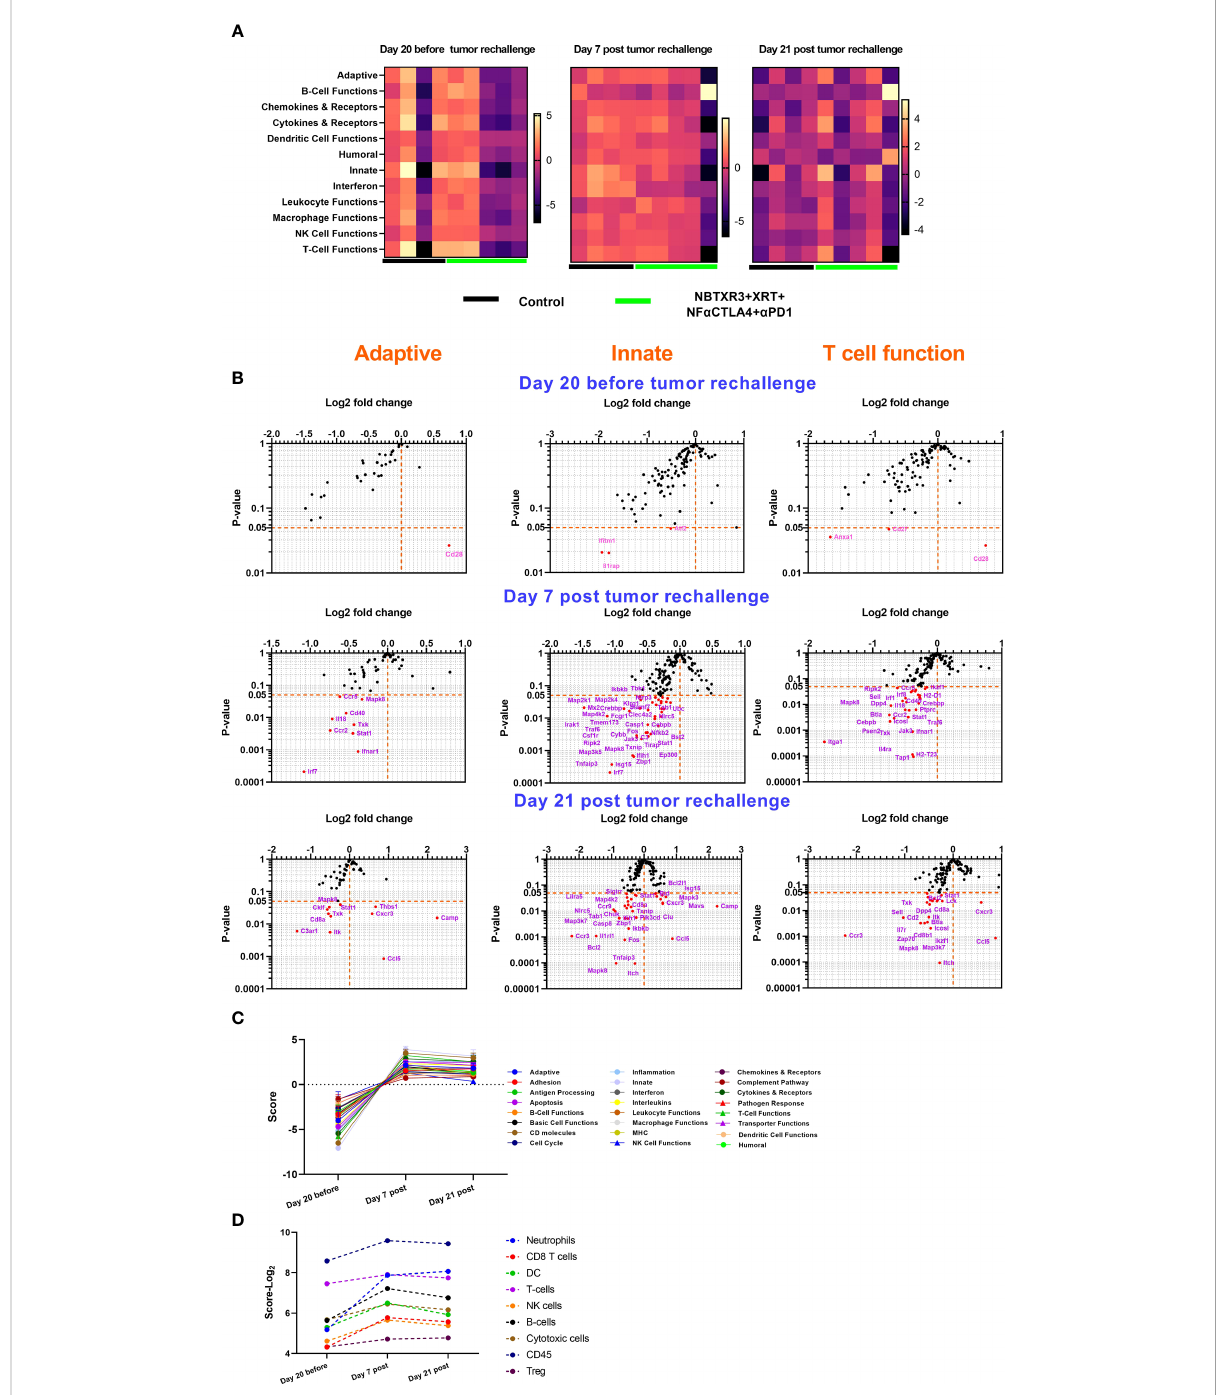
FIGURE 6 Survivor mice cured by NBTXR3 and NF- a CTLA4 mediated immunoradiotherapy upgrade immune response to prevent tumor relapse. (A) Comparison of immune pathway activities of survivor and control mice. (B) Differences in immune-related gene expression in survivor mice relative to the control. (C) Immune pathway activities in survivor mice before and post tumor rechallenge. (D) Immune cell abundance in survivor mice before and post tumor rechallenge. The survivor mice in the NBTXR3+XRT+NF- a CTLA4+ a PD1 group were rechallenged with 344SQR cells 156 days post the last radiation fraction. RNA from blood harvested 20 days before, 7 and 21 days post tumor rechallenge were analyzed by